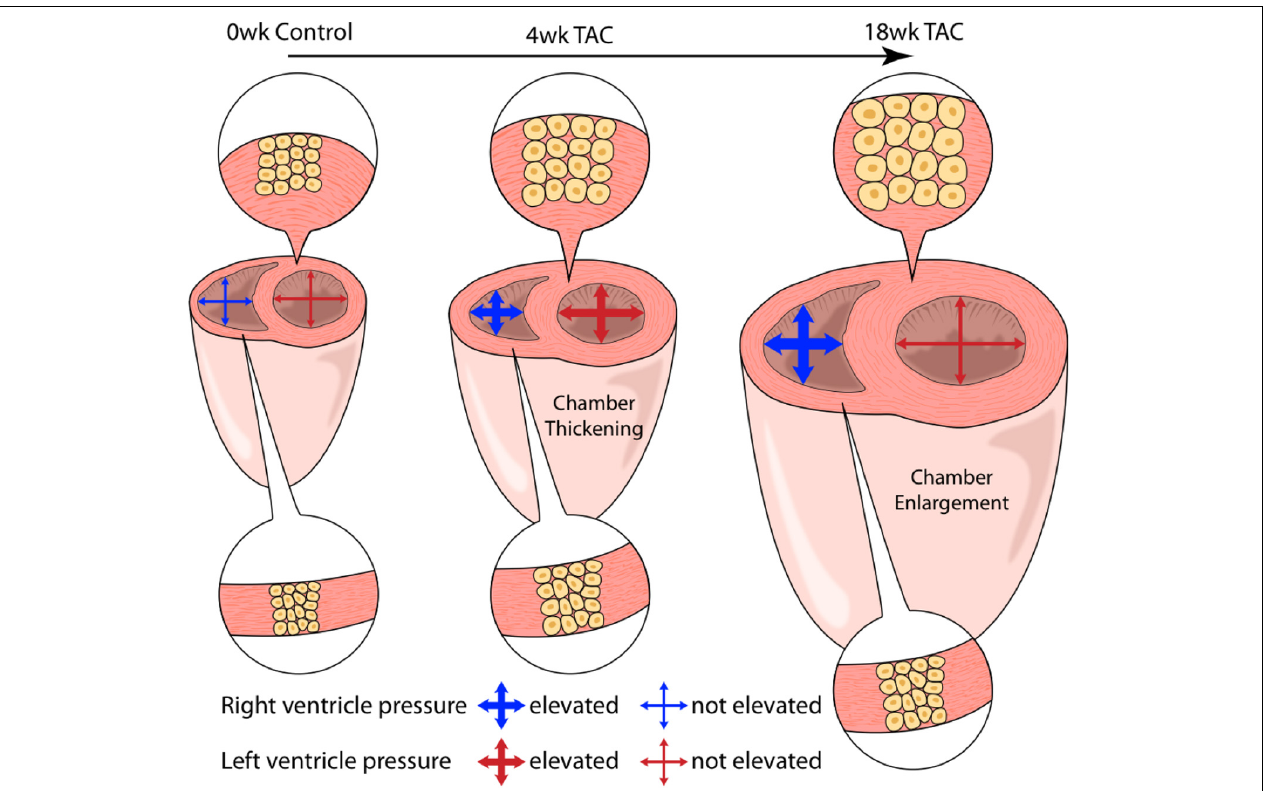
FIGURE 9 | An artistic depiction of the hypertrophic response in both ventricles over 18 weeks of TAC. At 4 weeks, both the right (RV) and left (LV) ventricles present with concentric hypertrophy (thickening of ventricle walls with an increase in cardiomyocyte cross-sectional area (CSA). LV concentric hypertrophy continued out to 18 weeks despite declining systolic pressures. Alternatively, RV cardiomyocyte CSA was static despite sustained systolic pressure-overload. Here, total weight increased in the absence of changes in CSA, suggestive of cardiomyocyte lengthening (eccentric